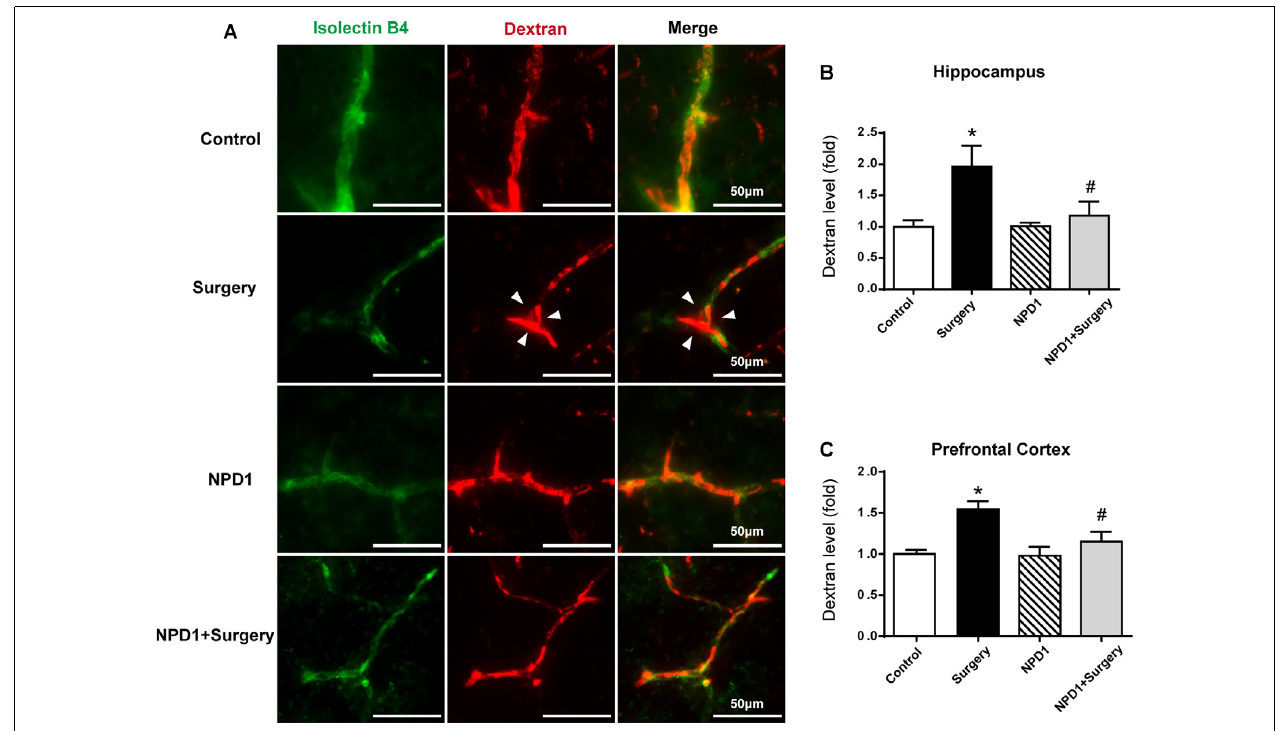
FIGURE 3 | NPD1 protects against the leakage of the blood–brain barrier (BBB) induced by surgery/anesthesia in the hippocampus and prefrontal cortex. Immunostaining of blood vessels (isolectin B4, green) and intravenously injected dextran (10 kDa, red) in brain sections of the hippocampus at 6 h after surgery (A) . The arrowhead marked area indicates that the dextran was extravascular. The spectrophotometric quantification of extravascular dextran (10 kDa) levels in the extraction of the hippocampus and prefrontal cortex showed that surgery/anesthesia increased the permeability of the BBB compared with the control, and pretreatment with NPD1 attenuated this phenomenon (B,C) . Data are presented as mean ± SEM. Statistics: two-way ANOVA followed by Bonferroni post hoc comparison. (B,C ) n = 4–5 per group. * P < 0.05 vs. the control group, # P < 0.05 vs. the surgery group. Scale bars represent 50 µ m in (A)